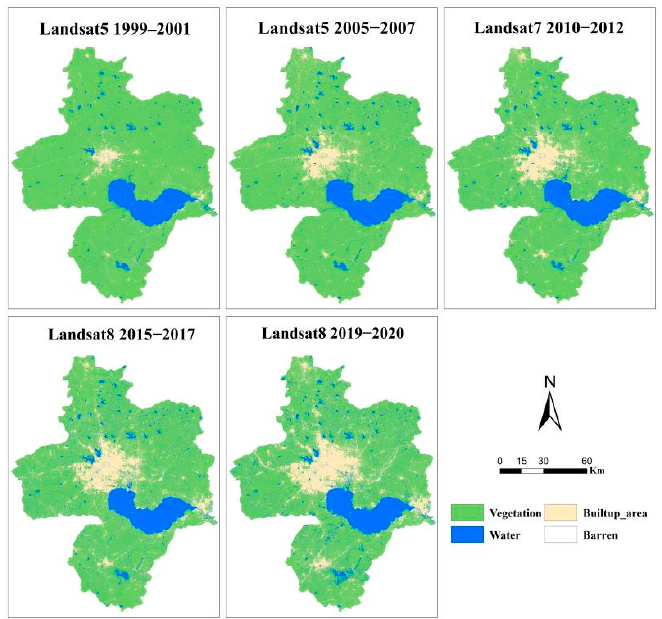
Figure 4. Comparison of different land cover products in 2020. ( A ) Landsat annual TOA false-color composition in 2020 (RGB: B5, B4, B3), ( B ) GLC_ FCS30, ( C ) GlobeLand30, and ( D ) this product. Comparison of different kinds of land cover types from 1 to 8.